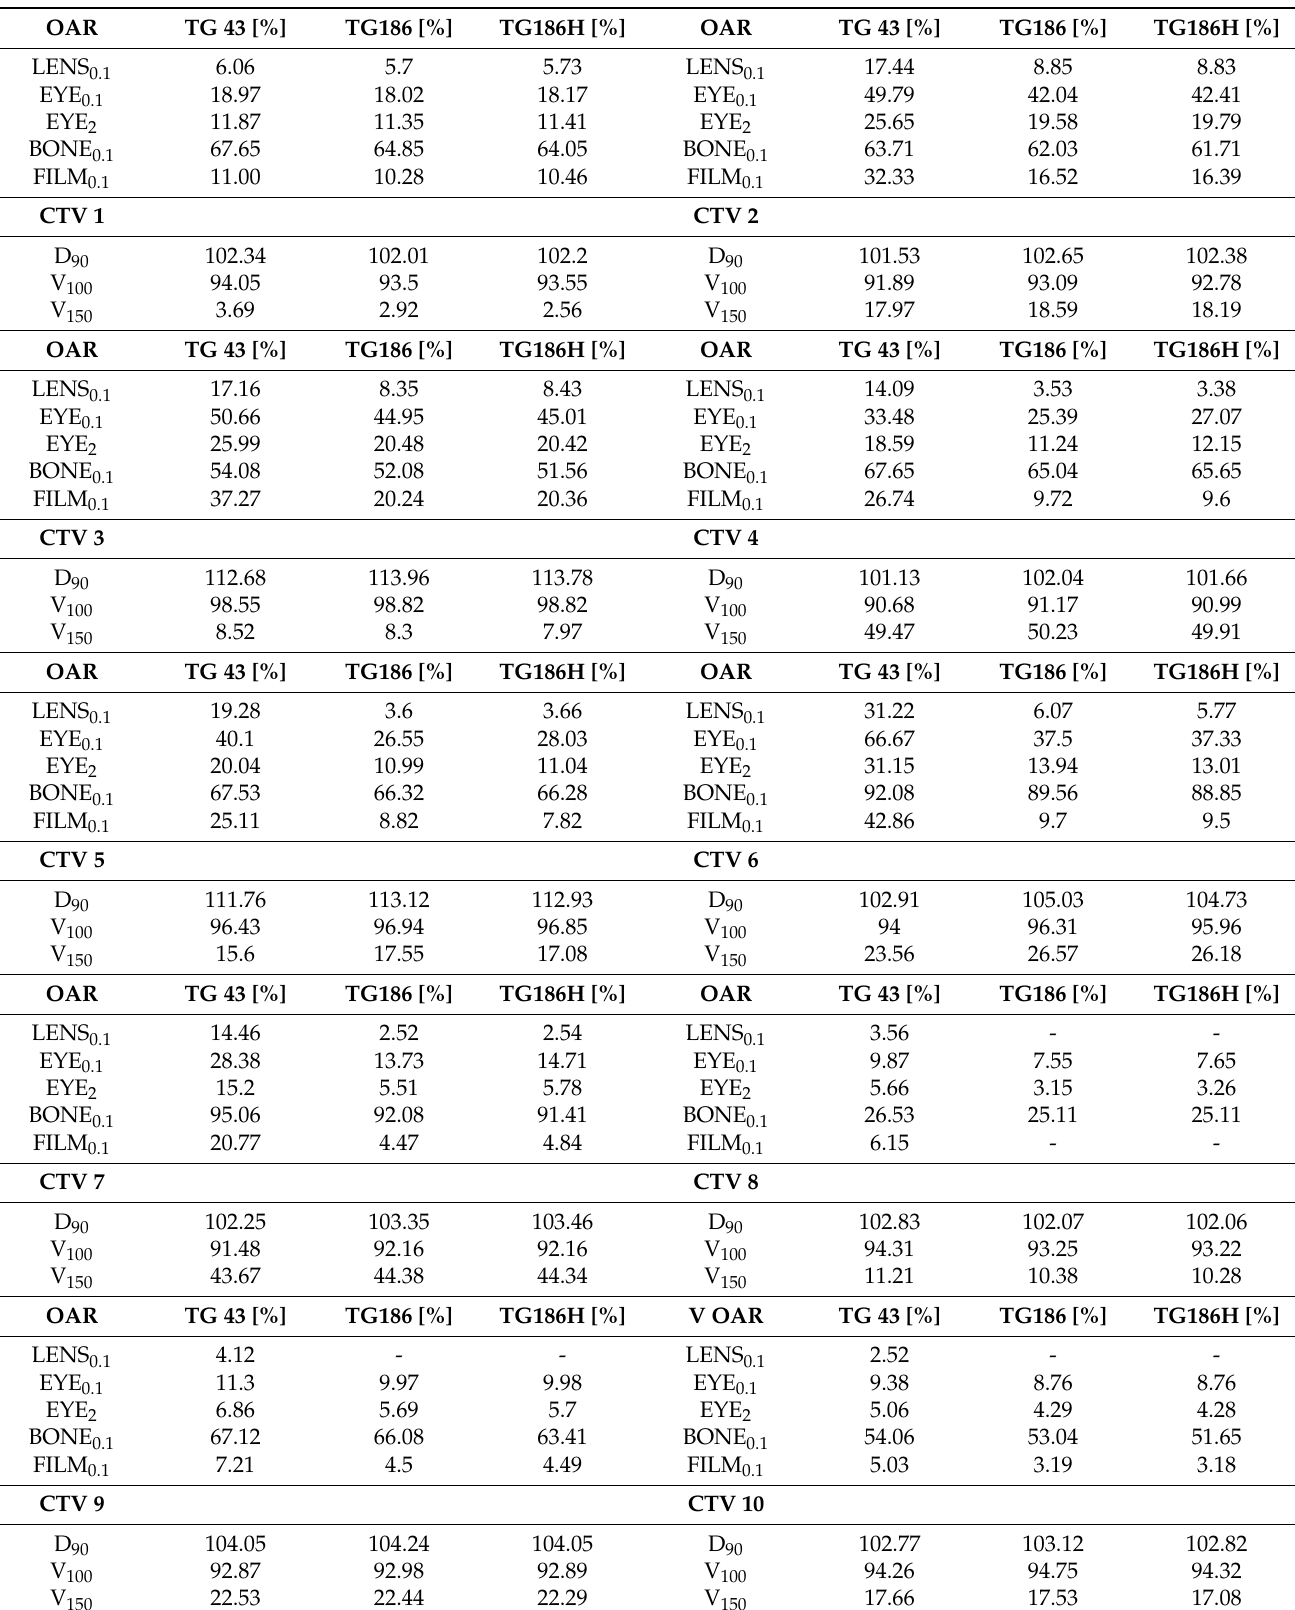
Table 1. Calculated dose-distribution parameters for analyzed volumes of critical organs (OAR)